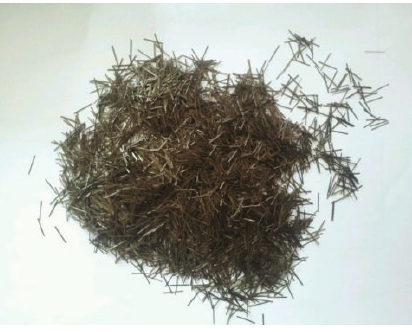
Figure 1: Basalt fiber.